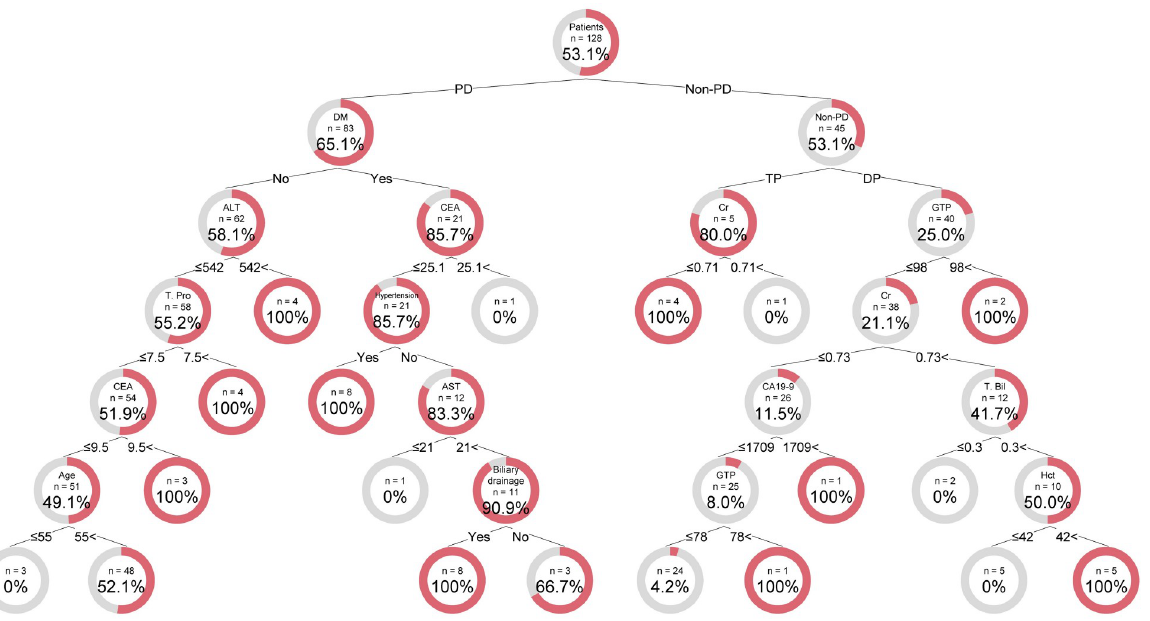
PLOS ONE | https://doi.org/10.1371/journal.pone.0259682 November9,